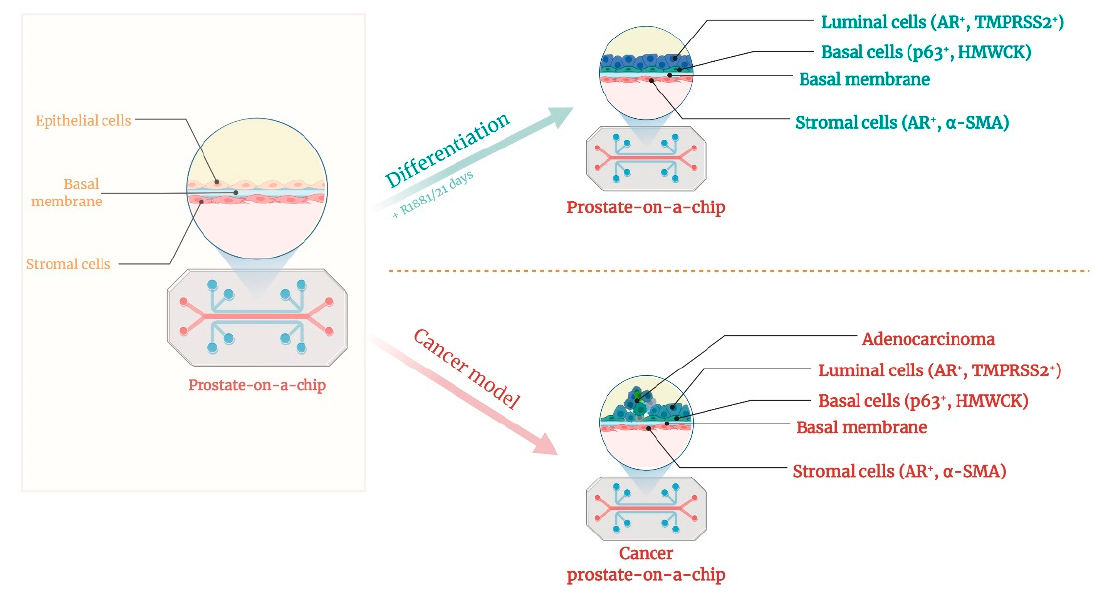
Figure 3. Prostate-on-chip. Figure 3.